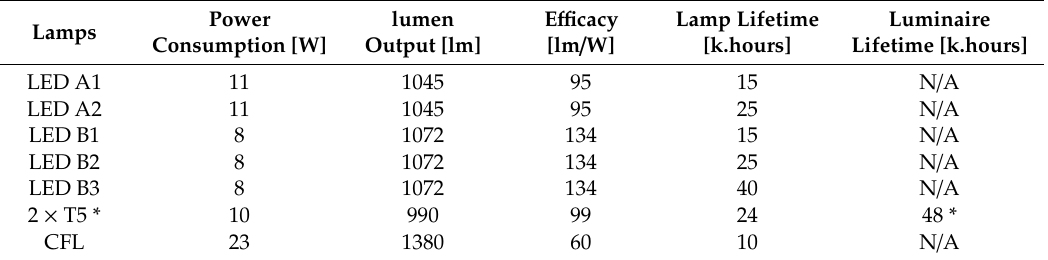
Table 1. Performance parameters for lamps. LED A: the firsts lamps available on the French market, LED B: the latest product available following a projection plan from the US Department of